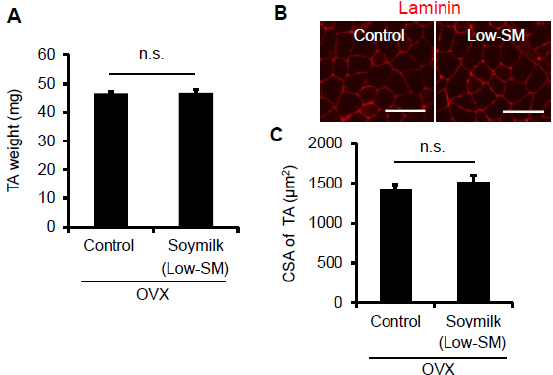
Figure 2. Effect of Low ‐ SM intake on muscle in OVX mice. OVX mice were fed with Low ‐ SM for 24 weeks as shown in Figure 1. ( A ) Muscle weight of TA was measured at 24 weeks followed by the start of soymilk intake. ( B ) Representative images of immunohistochemistry for laminin. ( C ) Cross ‐ sectional area (CSA) of TA muscle (at least 1200 myofibers per mouse were counted). (Control, n = 5; soymilk, n = 5 mice). Data represent the mean ± SEM. n.s., not significant. An asterisk denotes a significant difference from control ( * p < 0.05). Scale bar, 100 μ m.